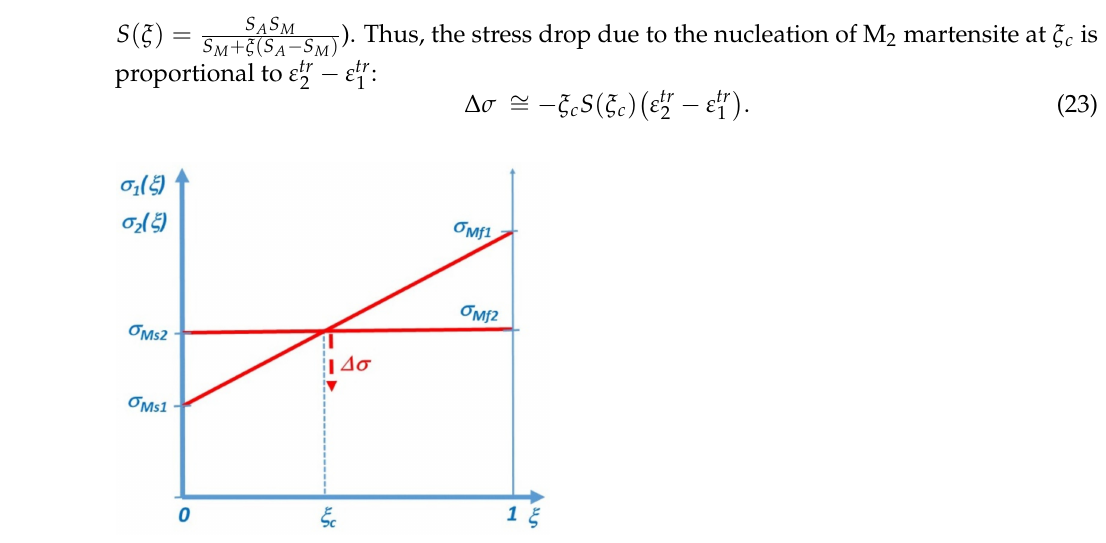
Figure 3. Schematic σ 1 ( ξ ) and σ 1 ( ξ ) functions, and the stress drop, ∆ σ at the critical volume fraction where the second martensite nucleates (see also the